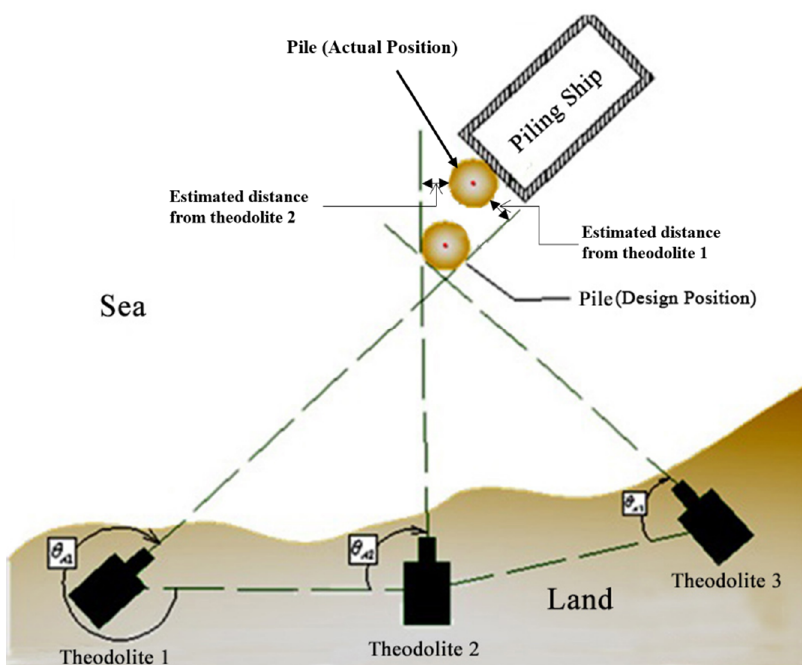
Figure 1. Traditional method for pile positioning of offshore piling.